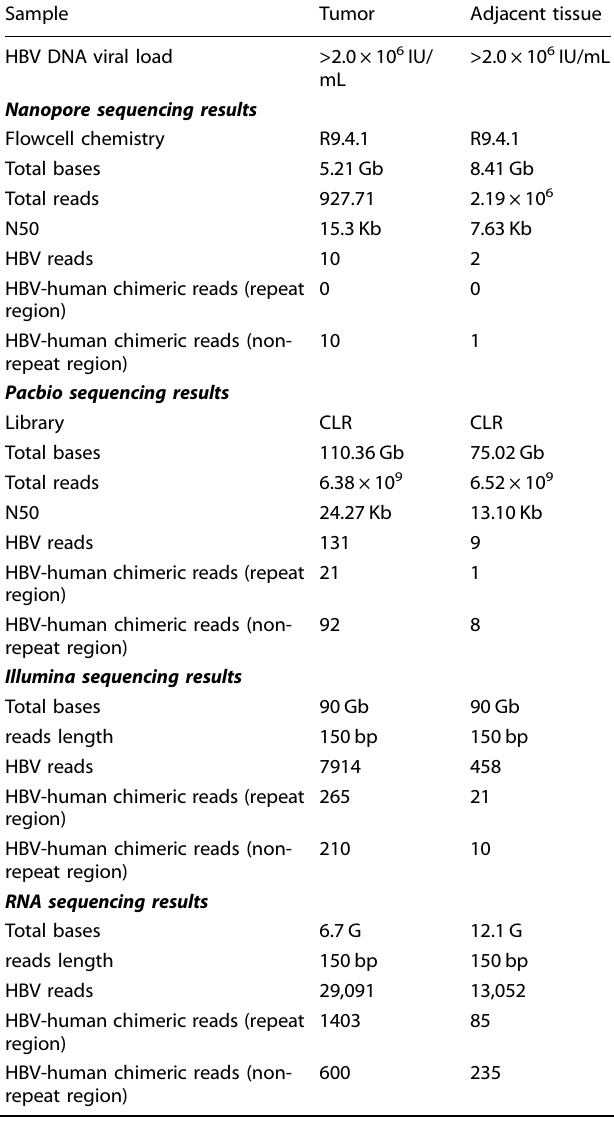
Table 1. The summary of the sequencing results.